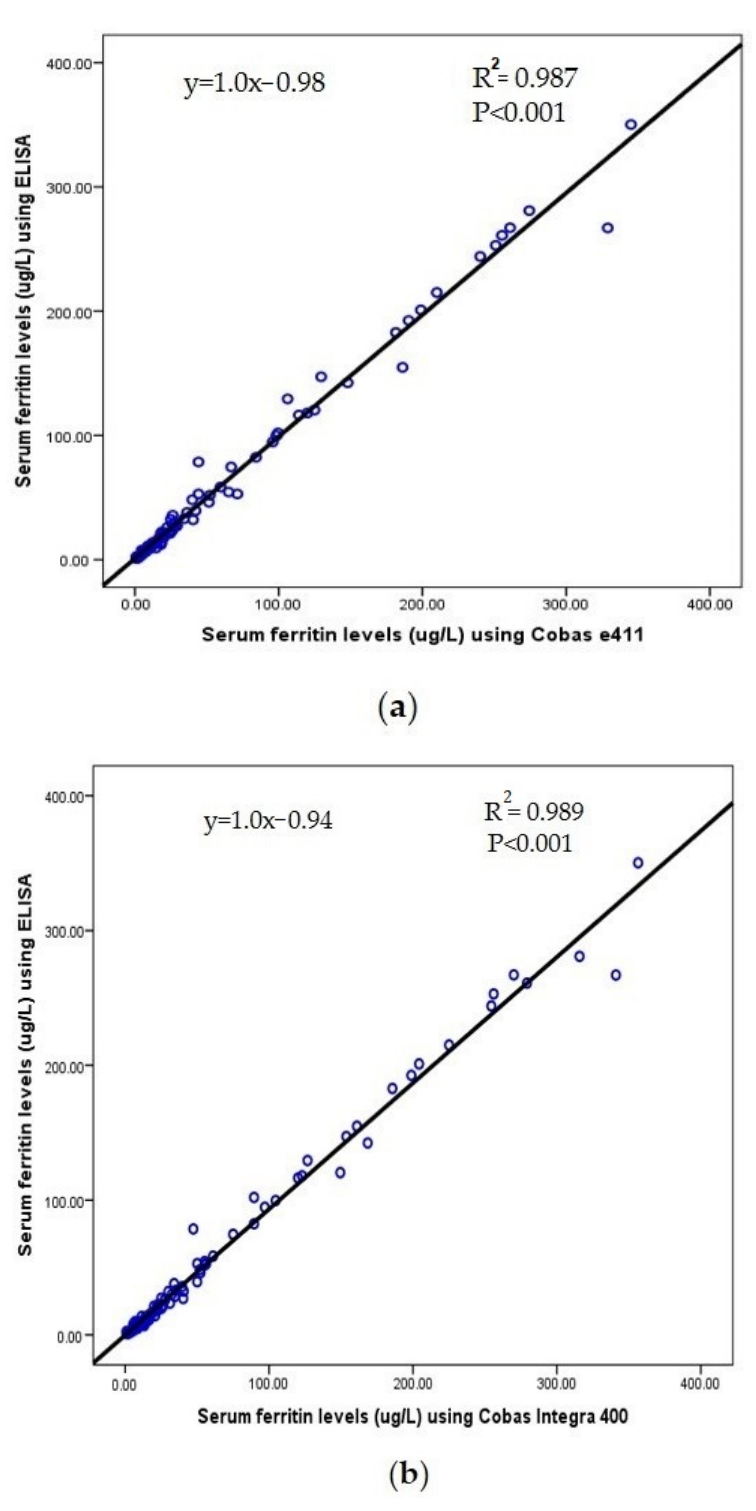
correlation between the Cobas e411 and Cobas Integra 400 results (r = 0.996, p < 0.001) (Figure 1c). In contrast, the linear regression equation for serum ferritin levels measured with ELISA compared to the Cobas e411 and Cobas Integra 400 methods (y = 1.0x − 0.98; R 2 = 0987, y = 1.0x − 0.94; R 2 = 0.989, respectively), while the results between the Cobas e411 and Cobas Integra 400 methods were: y = 0.87x − 0.95; R 2 = 0.992.